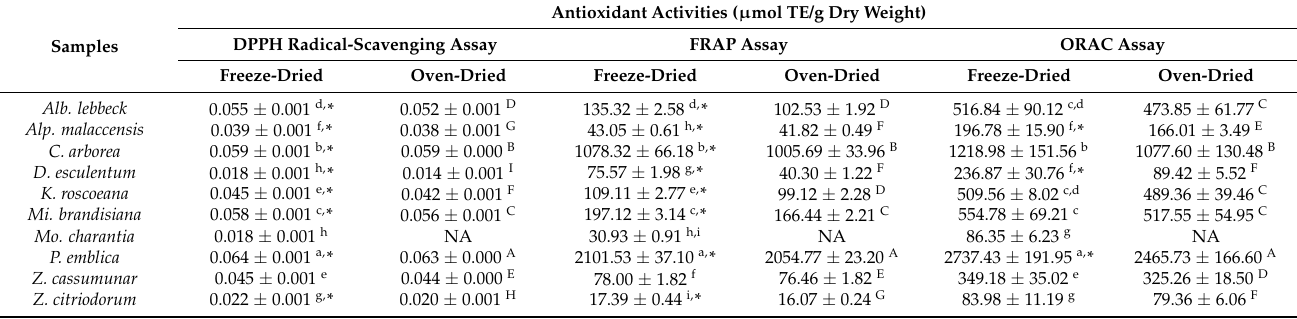
Table 3. Antioxidant activities of 10 indigenous plant extracts that prepared from freeze-drying and oven-drying